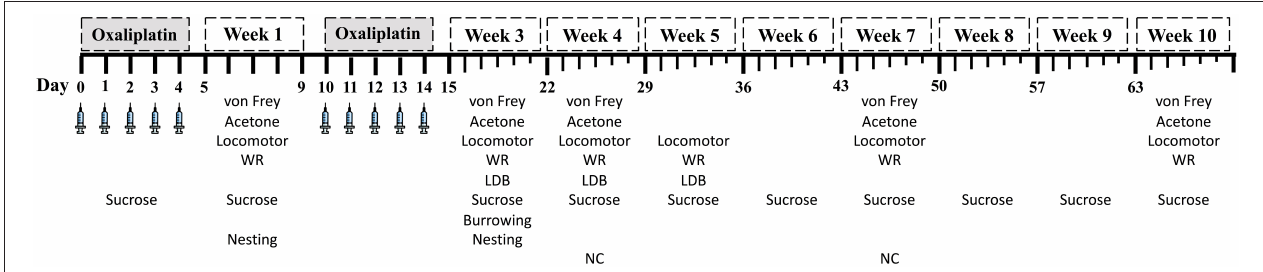
FIGURE 1 | Experimental testing schedule. Weeks 1 and 2 spanned 5-day intervals. Starting at week 3, testing week span for 7 days. LDB, light/dark boxes; WR, wheel running; NC: caudal nerve conduction.